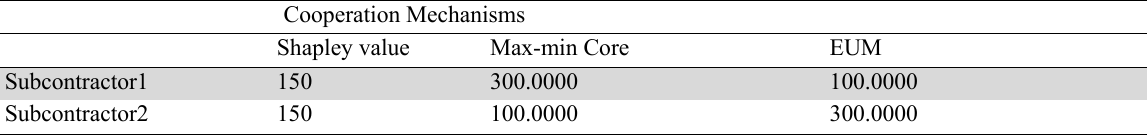
Cooperation mechanisms with two